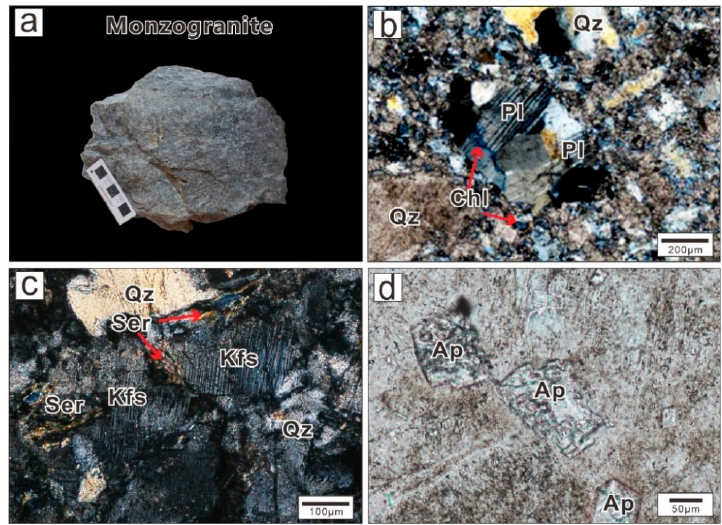
Figure 4. Photomicrographs showing the Muniushan monzogranite samples. Hand specimens of the Paleoproterozoic Muniushan monzogranites ( a ). Transmitted crosspolarized light photomicro- graphs ( b , c ). Single polarized photomicrograph ( d ). Pl = plagioclase, Qz = quartz, Chl = chlorite, Kfs = K-feldspar, Ser = sericite, Ap = apatite